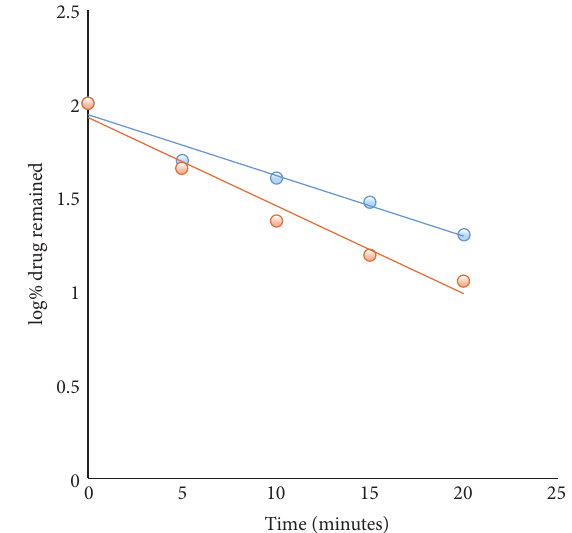
Figure 6: Effect of temperature (40 ∘ C, 50 ∘ C) on the degradation of DD in acidic